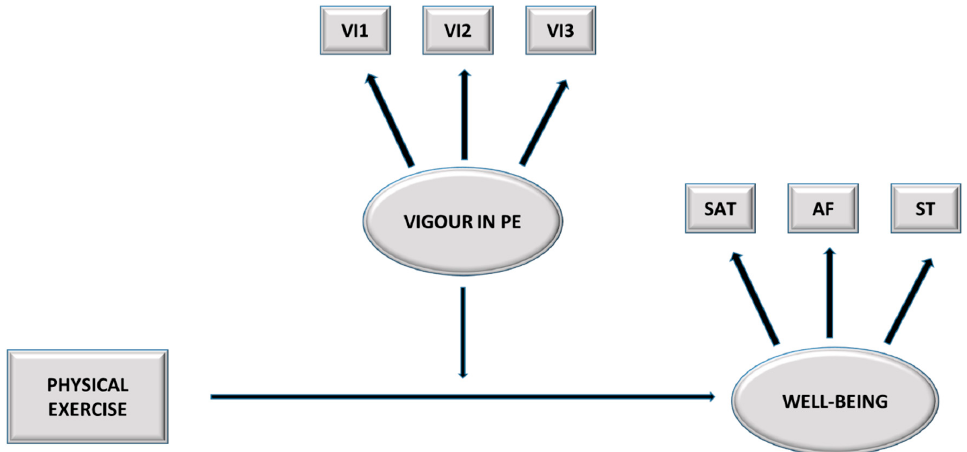
Figure 1. Hypothesized model. PE = Physical Exercise; VI1 = Item 1; VI2 = Item 2; VI3 = Item 3; SAT = Job satisfaction, AF = Positive affect, ST = Stress.